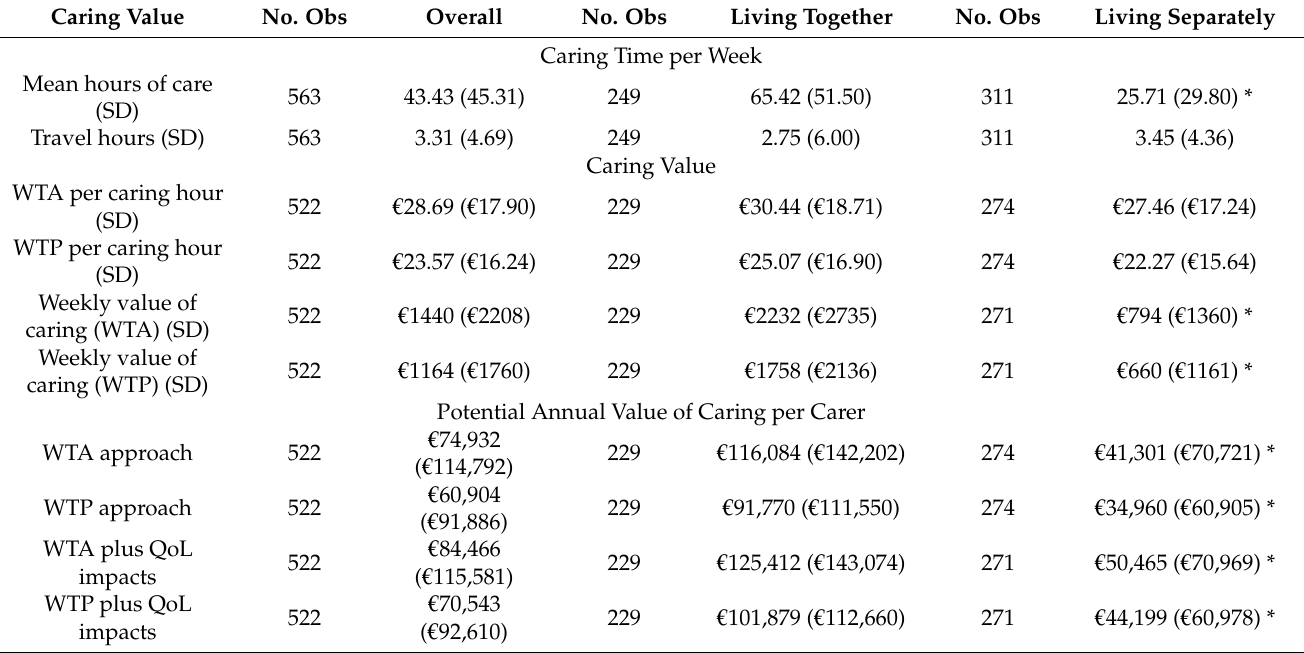
Table 5. Value of